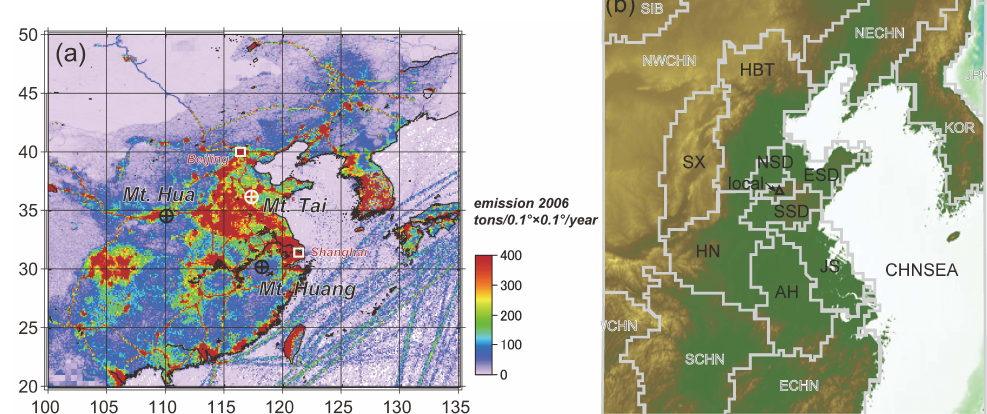
Fig. 1. (a) Geographical locations of Mt. Tai, Mt. Hua and Mt. Huang superimposed on EDGAR v.4.2 emission inventory map of NO x (2006). (b) Terrain of CEC and the major source regions used in the NAQPMS model simulations (see Sect. 6.3 for more details). Location of Mt. Tai is indicated by a